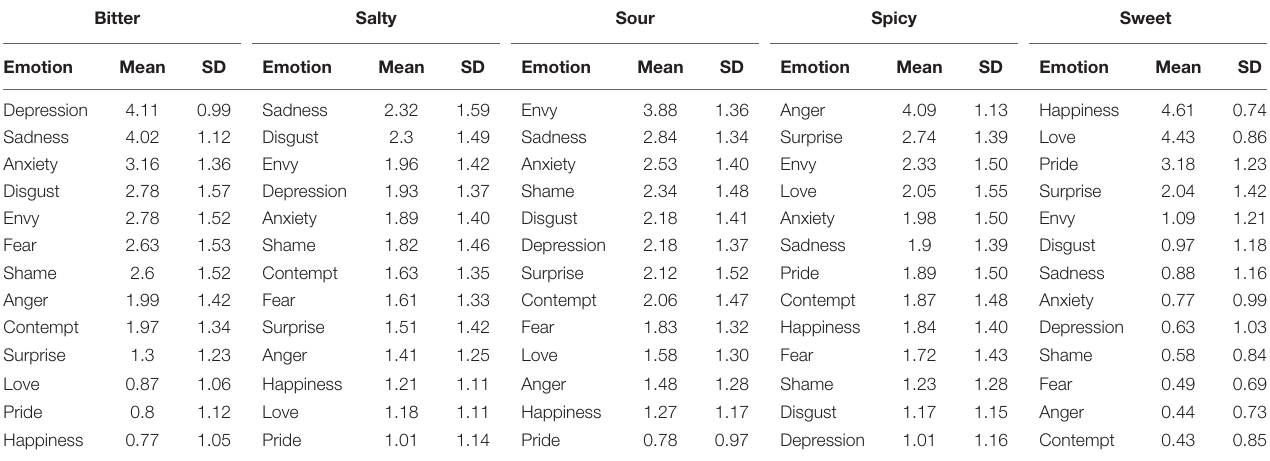
TABLE 3A | The means and standard deviation for the rating on taste-emotion associative strength. Bitter Salty Sour Spicy Sweet